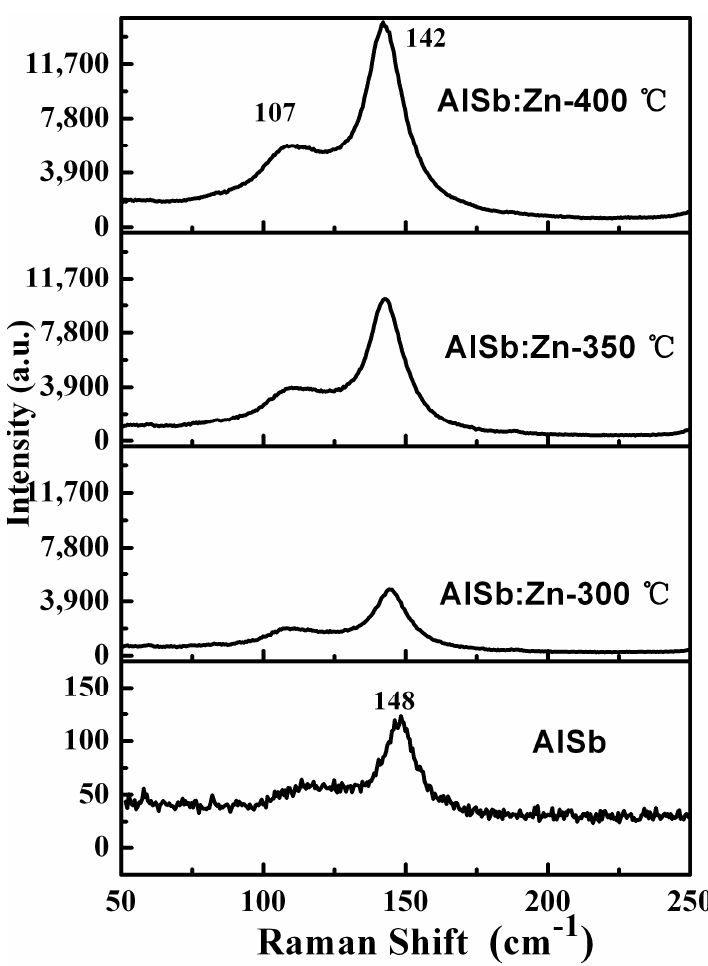
Figure 4. Raman spectra of AlSb:Zn thin films deposited at different substrate temperatures.